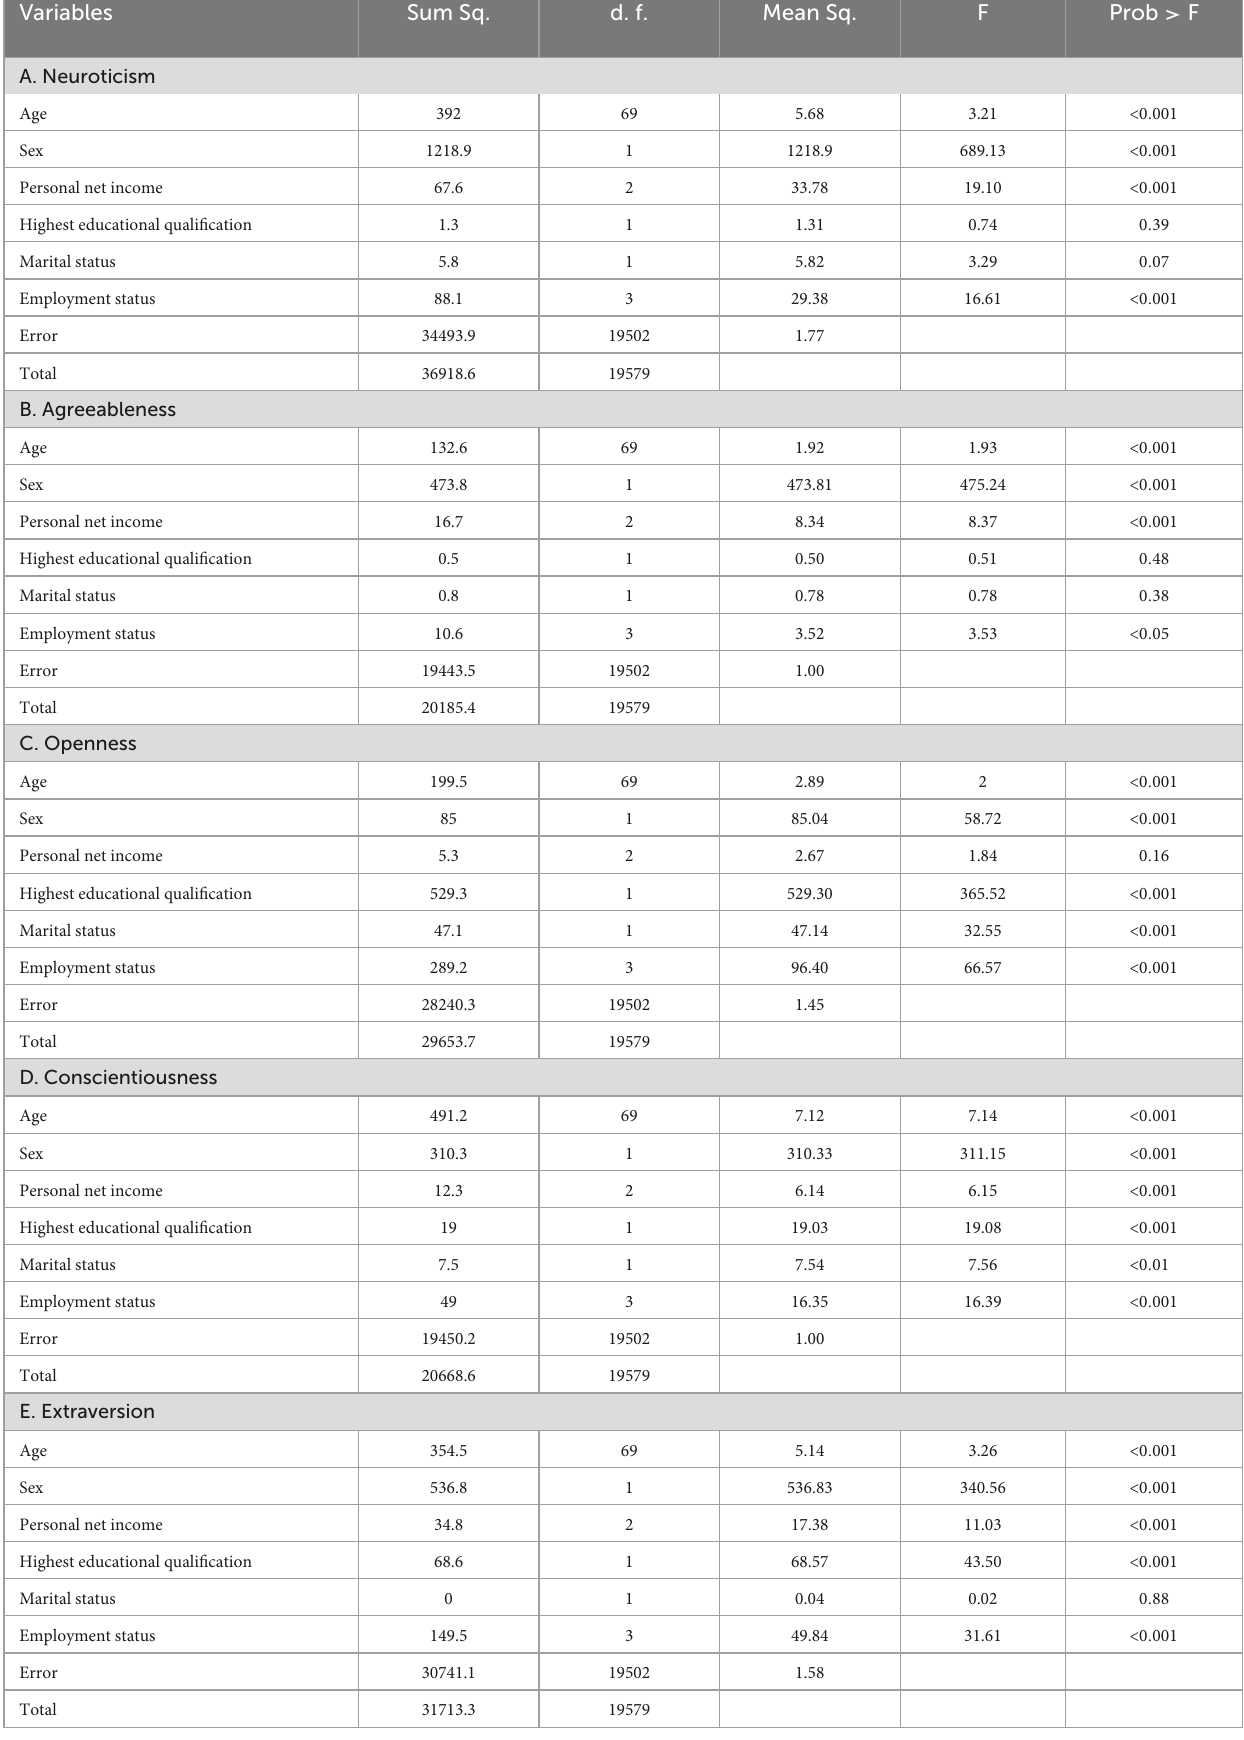
TABLE 2 The results of the ANOVA for A. Neuroticism, B. Agreeableness, C. Openness, D. Conscientiousness, and E. Extraversion respectively. Variables Sum